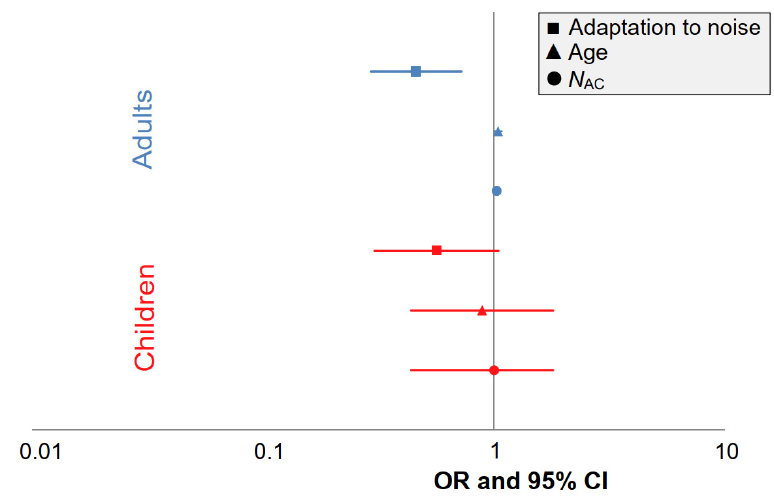
Figure 5. Forest plot depicting the OR and 95% CI for children ( N = 48, red) and adults from the STRAIN study ( N = 48, blue) for the acoustical and non-acoustical predictors of annoyance in model LR4.